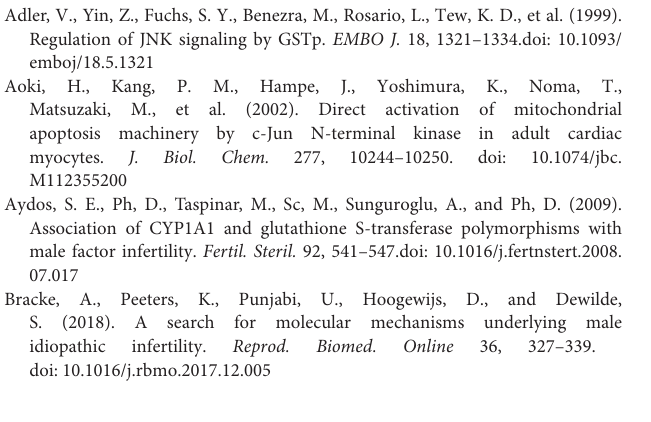
Supplementary Table 1 | Raw data. Raw data of sperm quality and functionality parameters of all treatments and time points. TMOT, percentage of total motile sperm; PMOT, percentage of progressively motile sperm; VAP, sperm average path velocity ( µ m/s); VIABILITY, percentage of viable sperm (SYBR-14 + /PI − ); M540, percentage of membrane-destabilized cells (M540 + ) within the total viable sperm population (Yo-Pro-1 − ); HE, relative fluorescence intensity of viable sperm